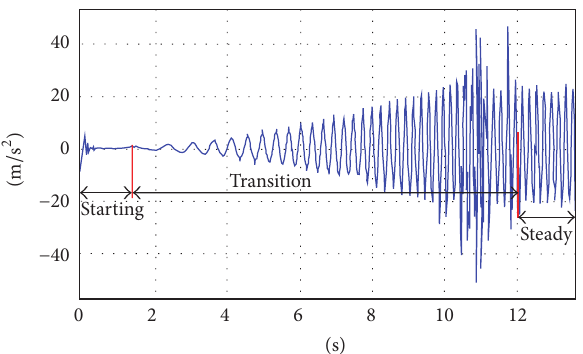
Figure 9: Simulated acceleration curve of the slider under the condition of zero-load operation.